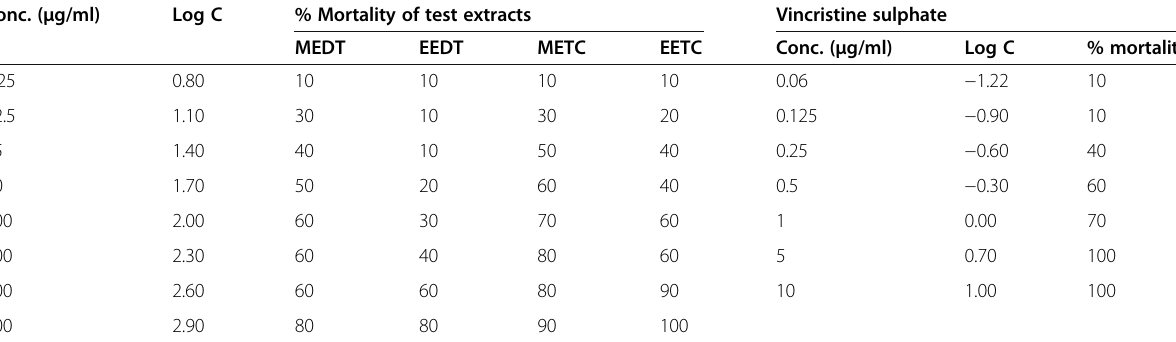
Table 5 The percentage mortality of brine shrimp nauplii after treating with different concentrations of test extracts ( n = 3) and the standard vincristine sulphate Conc. ( μ